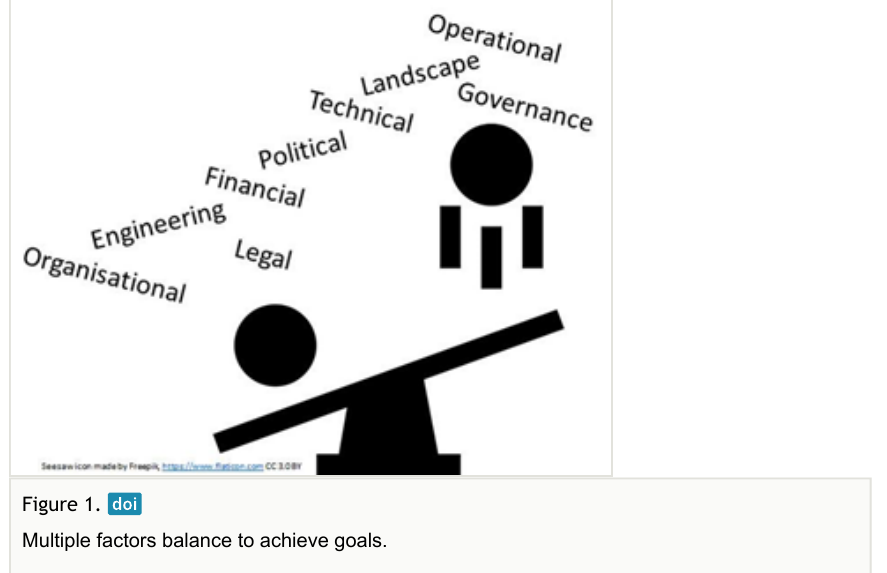
Multiple factors balance to achieve